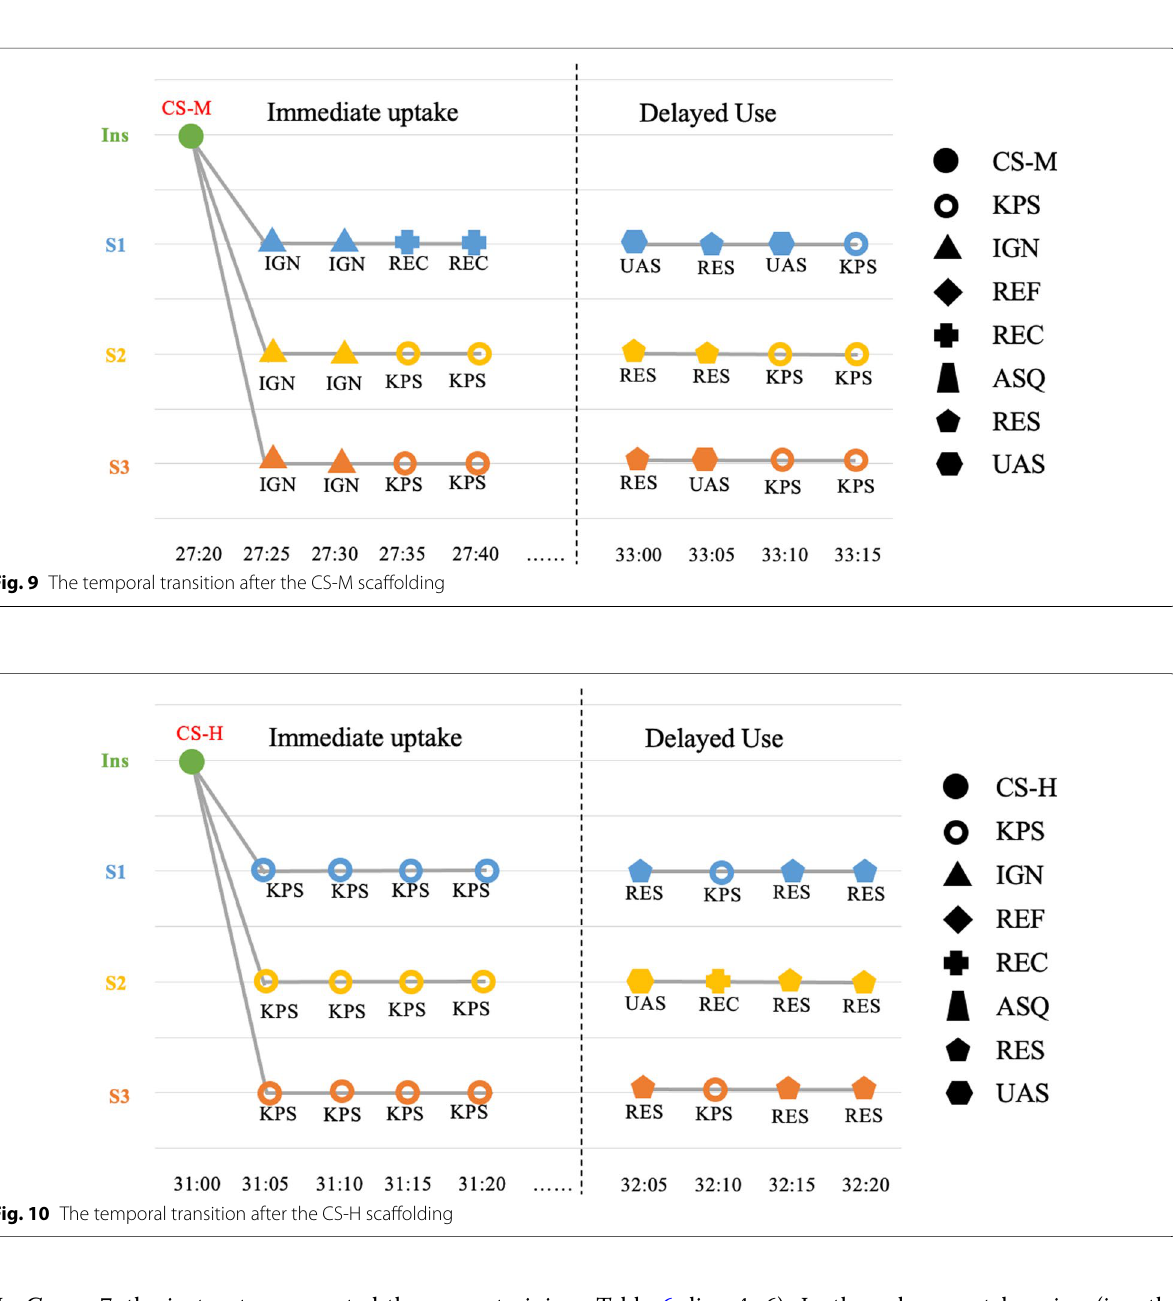
Table 6: line 4, 6). In the subsequent learning (i.e., the delayed use of scaffolding), S1 was also the first student to understand the instructor’s scaffolding and solved problems with programming (see Table 6: line 4, 6, 8, 12).